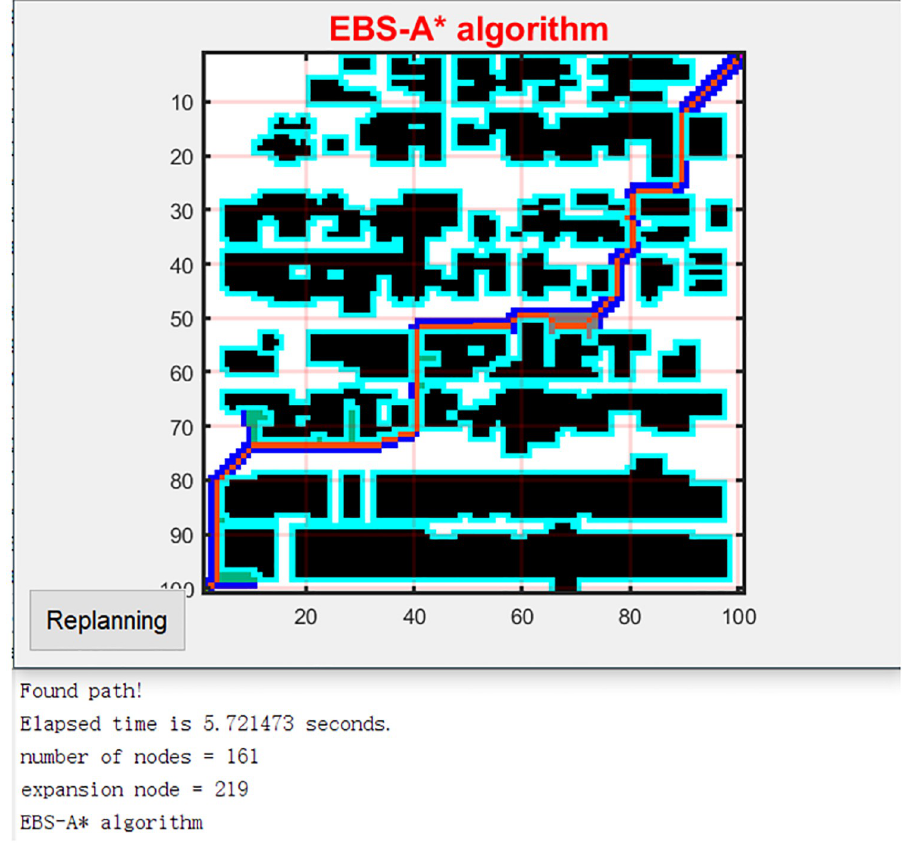
Fig 12. The path planning of the EBS-A � .